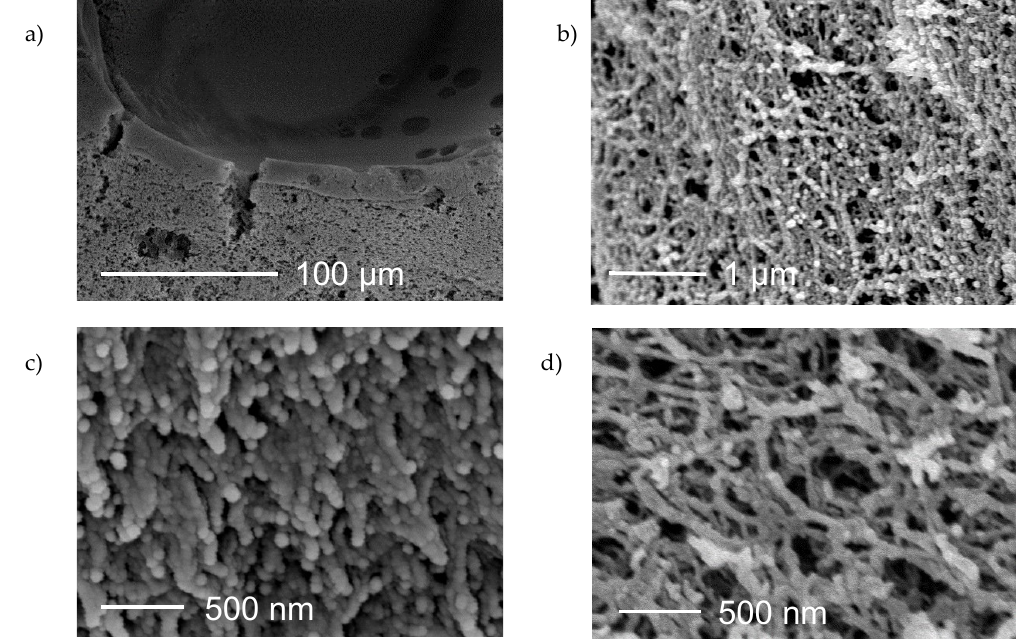
Figure 4. Scanning electron microscopy (SEM) images: a ) chitosan-coated pectin aerogels, the inner part (100 µm scale); b ) chitosan-coated pectin aerogels, the outer part (1 µm scale); c ) pectin aerogel (500 nm scale); and d ) chitosan-coated pectin aerogels (500 nm scale).